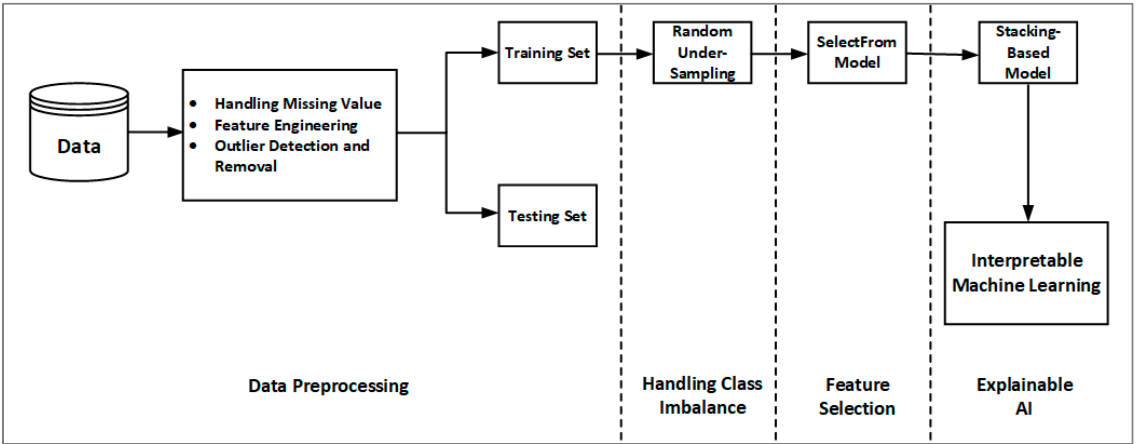
Figure 1. Workflow of Explainable AI-based framework.